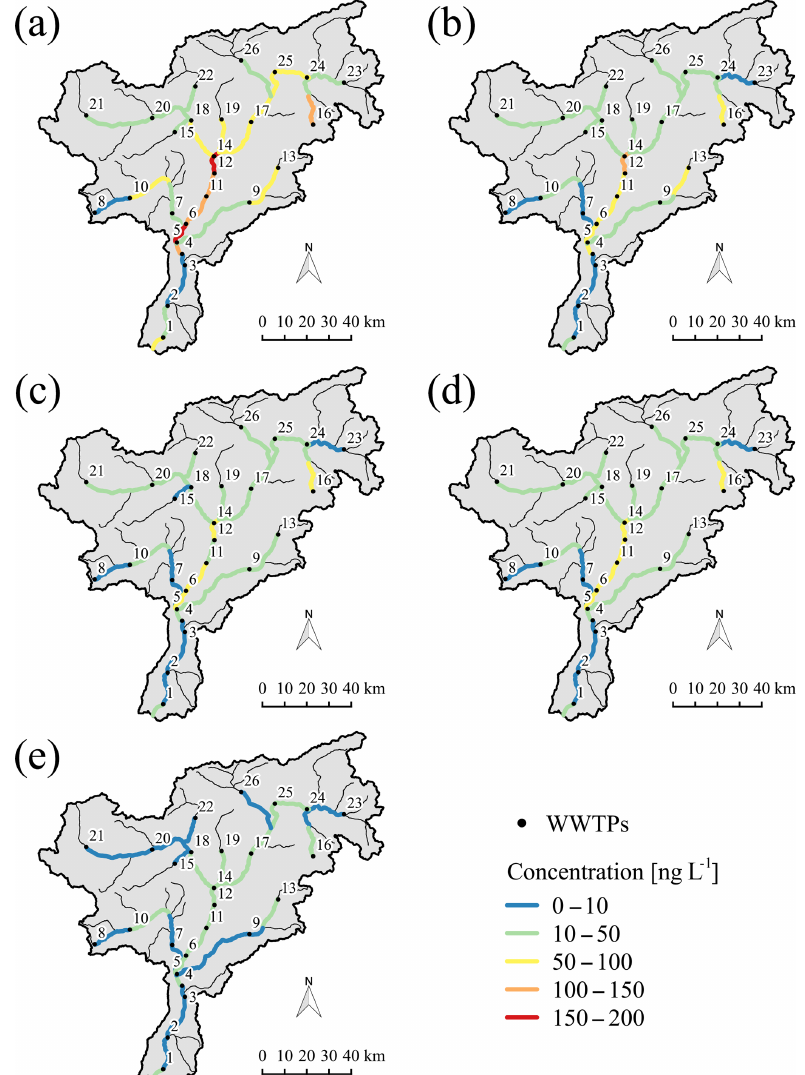
Figure 5. Annual mean concentrations of (a) diclofenac, (b) ketoprofen, (c) clarithromycin, (d) irbesartan and (e) sulfamethoxazole in the Adige catchment for the year 2015. The position of WWTPs along the river network are marked with a black bullet and numbered progressively from the southern control section in the main stem of the Adige River to the headwaters (see Table B1 in the Appendix B). Color scale is from blue (low concentration) to red (high